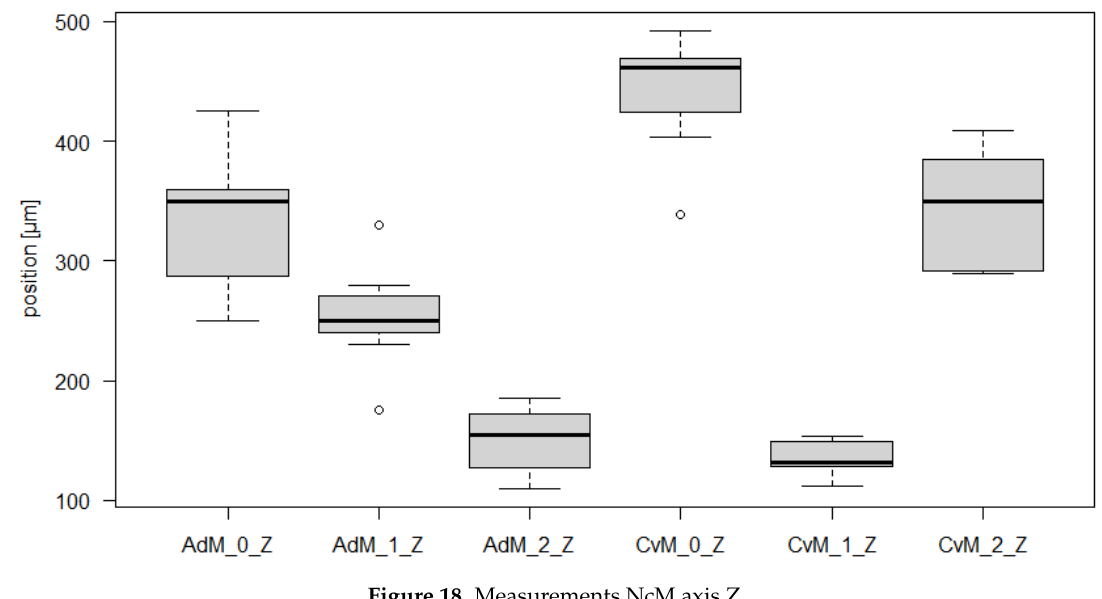
Figure 18. Measurements NcM axis Z.